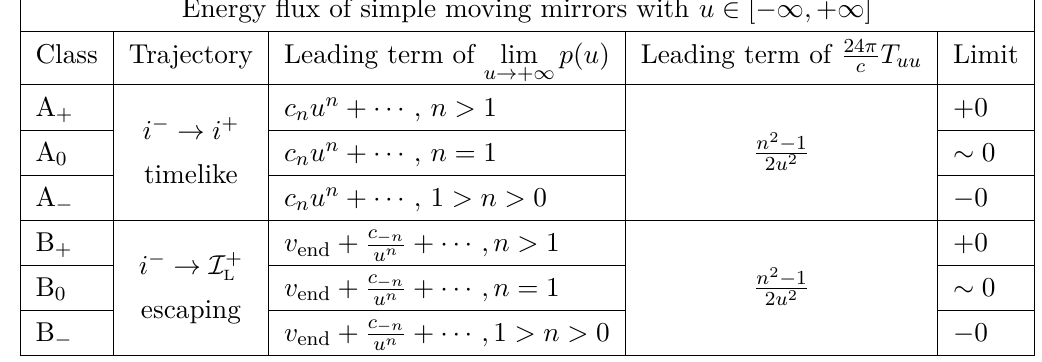
Table 2 . Classification of type A and type B mirrors based on the leading behavior of the mapping function p ( u ) . We assume that n is finite and